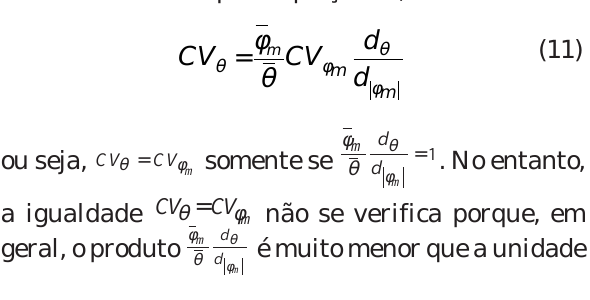
e f / q . d qqqqq /d fffff para as profundidades de 0,10, 0,20, m m m